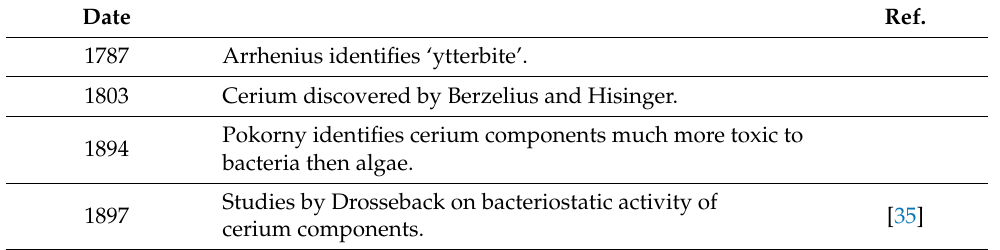
Table 1. Timeline of cerium discovery and its antimicrobial